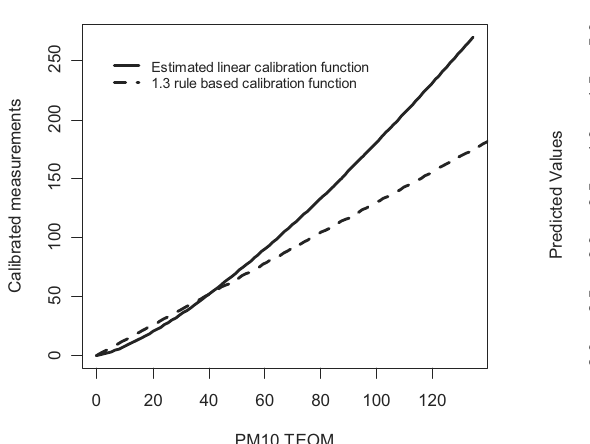
Figure 3 – Predicted vs observed TEOM meas- urements in the out of sample site 13.